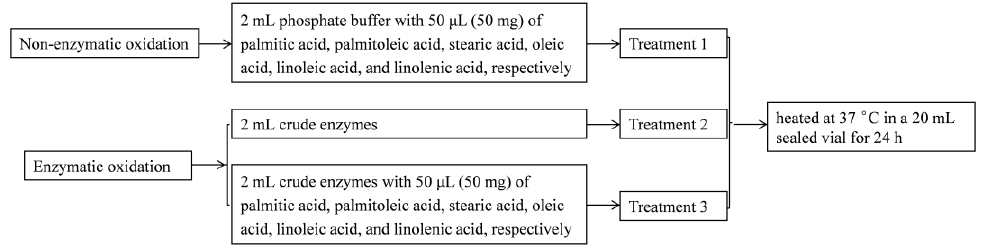
Figure 6. Experimental design to elucidate the relationships between the volatiles and fatty acids.